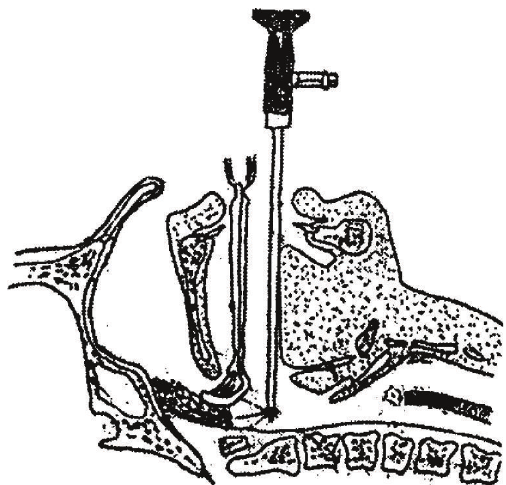
Figure 1: The adenoid curette inserted into the nasopharynx while the 70-degree nasal endoscope is introduced behind